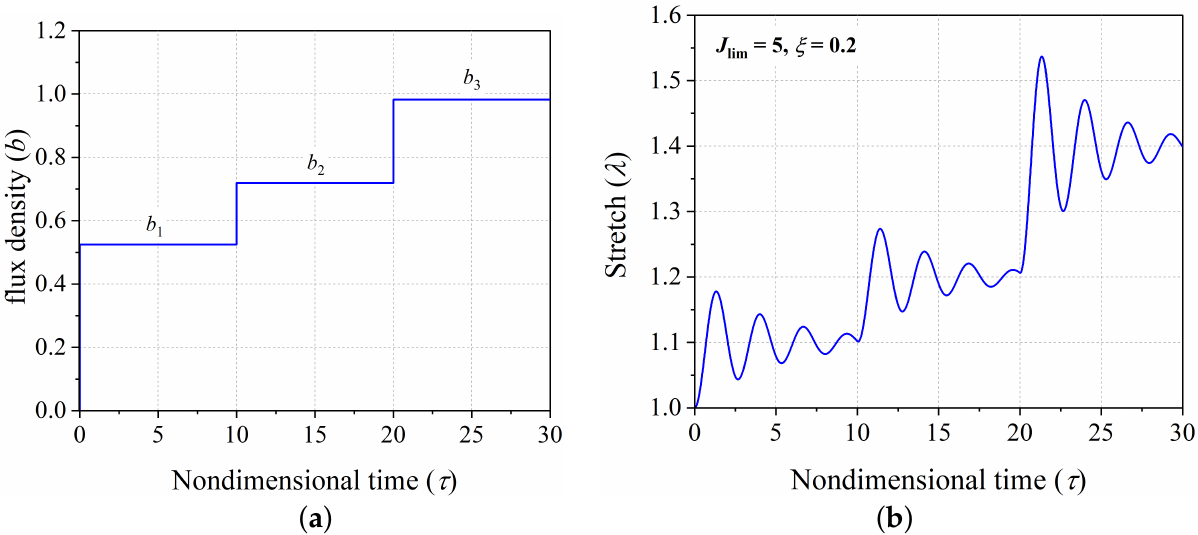
Figure 2. ( a ) A generic multi-step magnetic flux density input signal, and ( b ) the transient response of the hard-magnetic soft